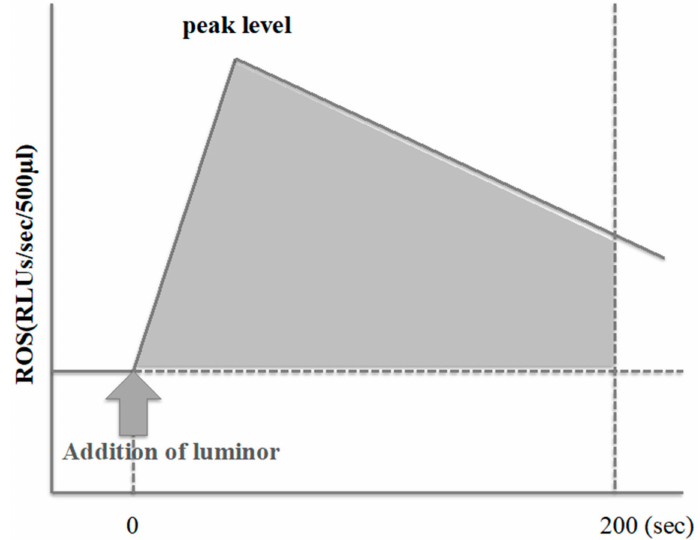
Figure 1. Measurement of reactive oxygen species (ROS) by chemiluminescence method. ROS production in the present study was calculated as the integrated chemiluminescence between 0 and 200 sec after the addition of luminol (5-amino-2,3-dihydro-1,4-phtalazinedione) to unwashed semen after baseline subtraction (expressed as relative light units (RLUs) / s / 200